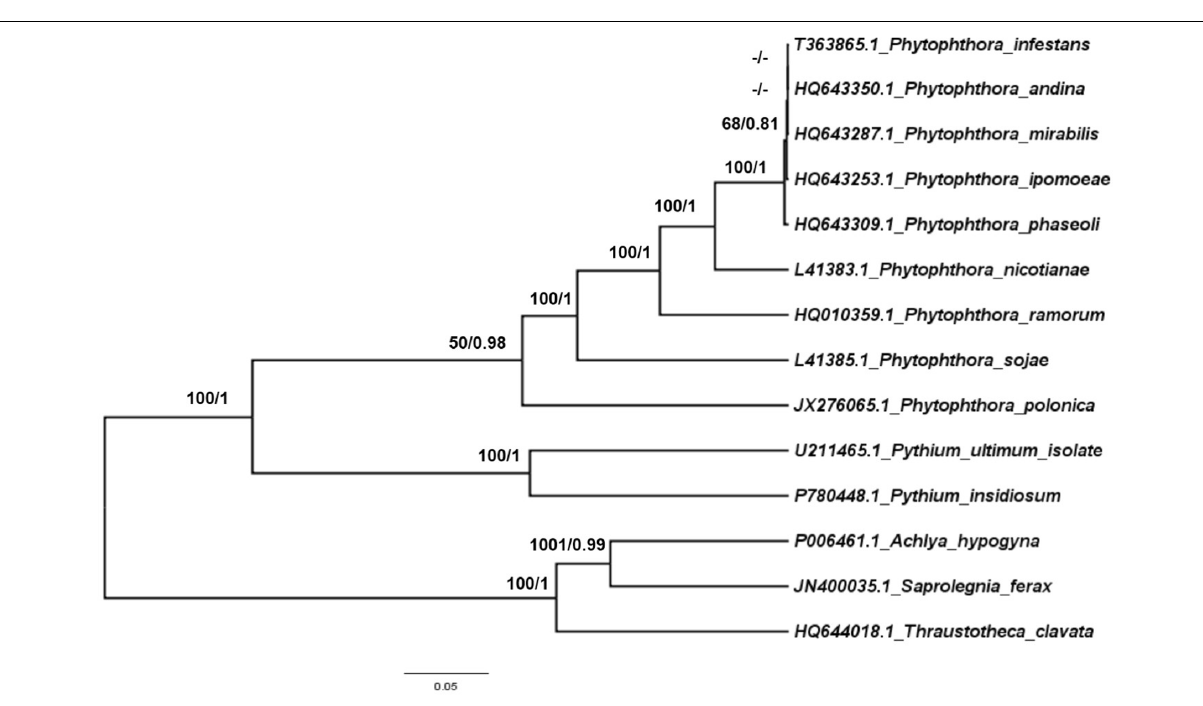
FIGURE 8 | Phylogenetic analysis of oomycetes species based on rDNA mitochondrial DNA sequences. ML and Bayesian trees were constructed based on rDNA mitochondrial DNA sequences. Bootstrap values (first value) and Bayesian inference (second value) are presented above the branches. Numbers at nodes are likelihood bootstrap values > 50% and posterior probabilities > 0.60 and maximum are